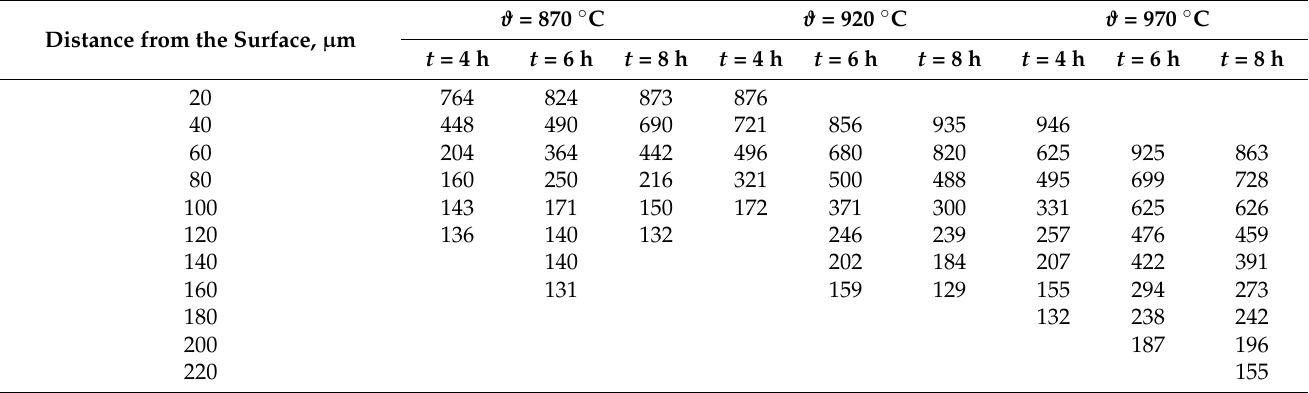
Table 12. Cross-sectional microhardness of the transition zone on boronized C15 steel, HV